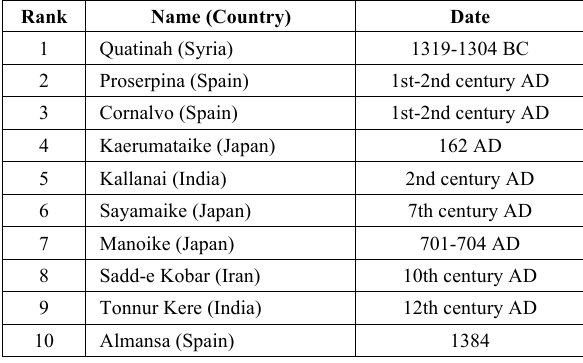
TABLE I. T EN O LDEST D AMS IN O PERATION